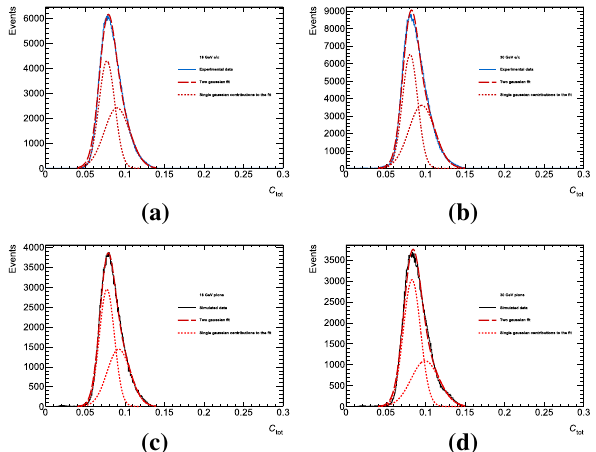
Fig. 10 The blue histograms in a and b show C tot distributions of experimental e /π sample events with E beam equal to 18 GeV and 30 GeV, respectively. Samples of pion events were selected requiring C long < 0.6. The black histograms c and d show the same distributions for simulated pion events selected applying the same selection criteria and with E beam equal to 18 GeV and 30 GeV, respectively. Two Gaussian functions fits, obtained using the method of the least squares, are over- lapped to the data (red dashed curves). Red dotted curves show the individual Gaussian